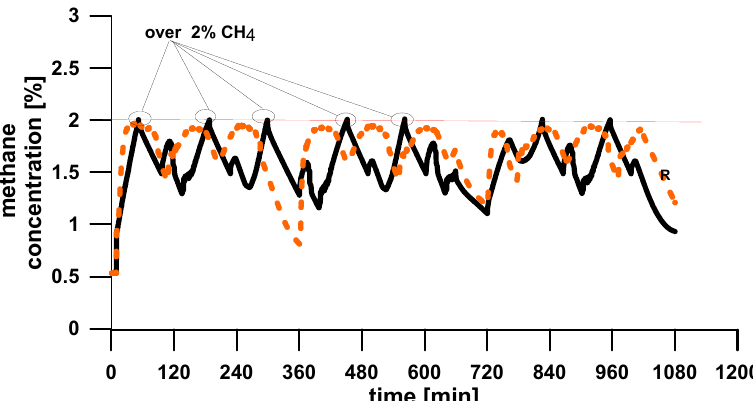
Figure 7. Changes in the methane concentration measured using a virtual sensor situated on the end of longwall, where the intermittent orange line represents a case with speed control and the black line indicates a case without speed control.